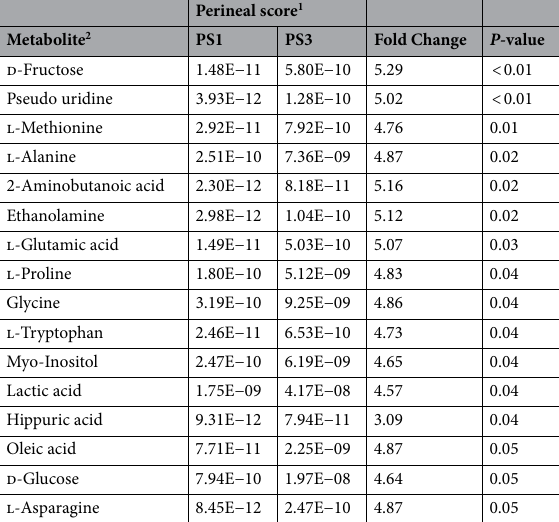
Table 2. Small molecule metabolites in serum from sows with differing risk of POP. 1 Sows were assigned a perineal score based on their relative risk of experiencing a pelvic organ prolapse (POP). Sows assigned PS1 were presumed low risk for POP while sows assigned PS3 were presumed high risk for POP. 2 Metabolite list only includes those that were identifiable and statistically significant ( P < 0.05) between perineal scores. Values reported as moles per